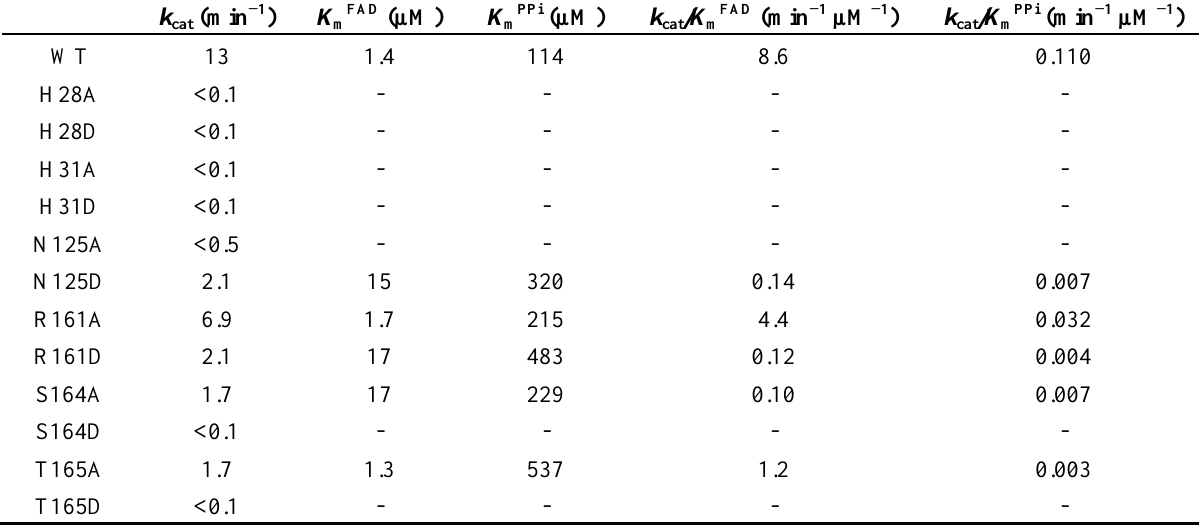
Table 2. Steady-state kinetic parameters for the FADpp activity (FAD + PPi → FMN